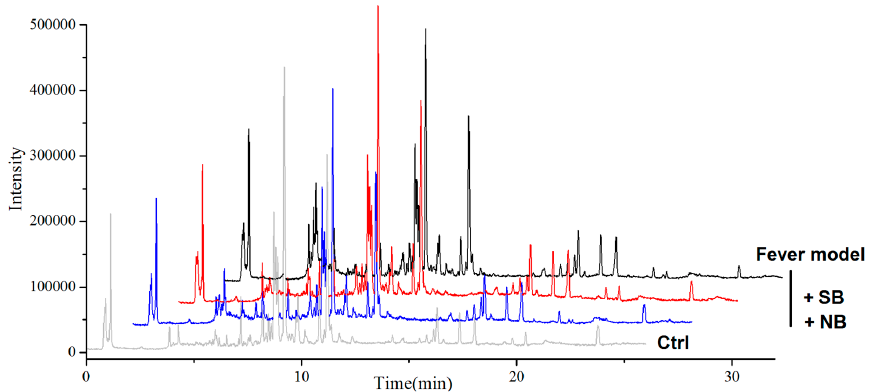
Figure 4. Representative ultra-performance liquid chromatography-quadrupole time-of-flight mass spectrometry (UPLC-Q-TOF/MS) TIC (total ion flow) chromatograms of the samples.